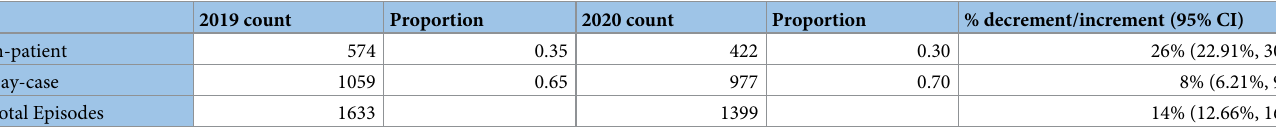
Table 2. In-patient, day- case based and total episodes in 2020 compared to